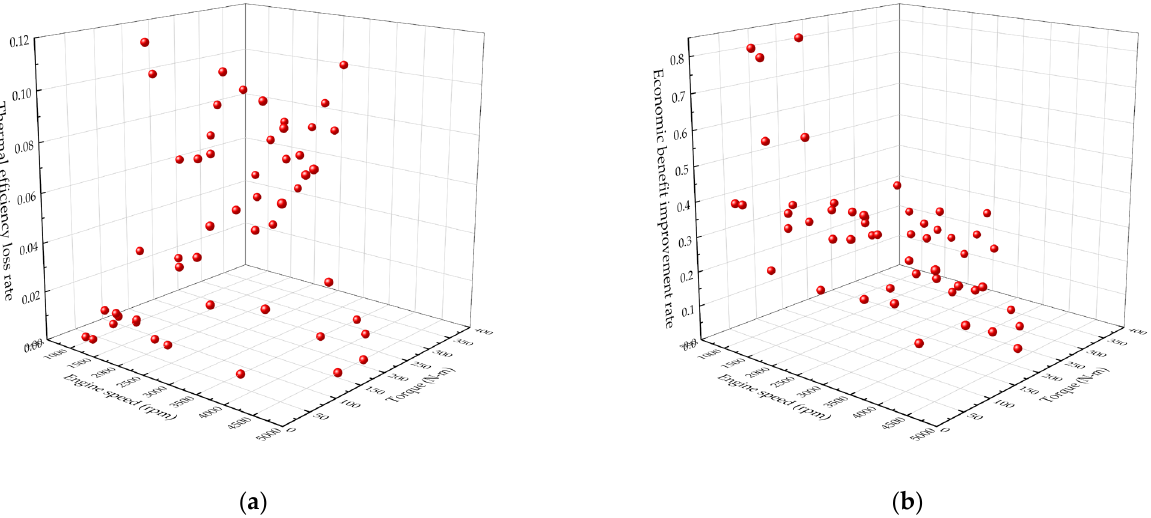
Figure 14. The optimization results of the two objectives: ( a ) thermal efficiency loss rate; ( b ) economic benefit improvement rate.